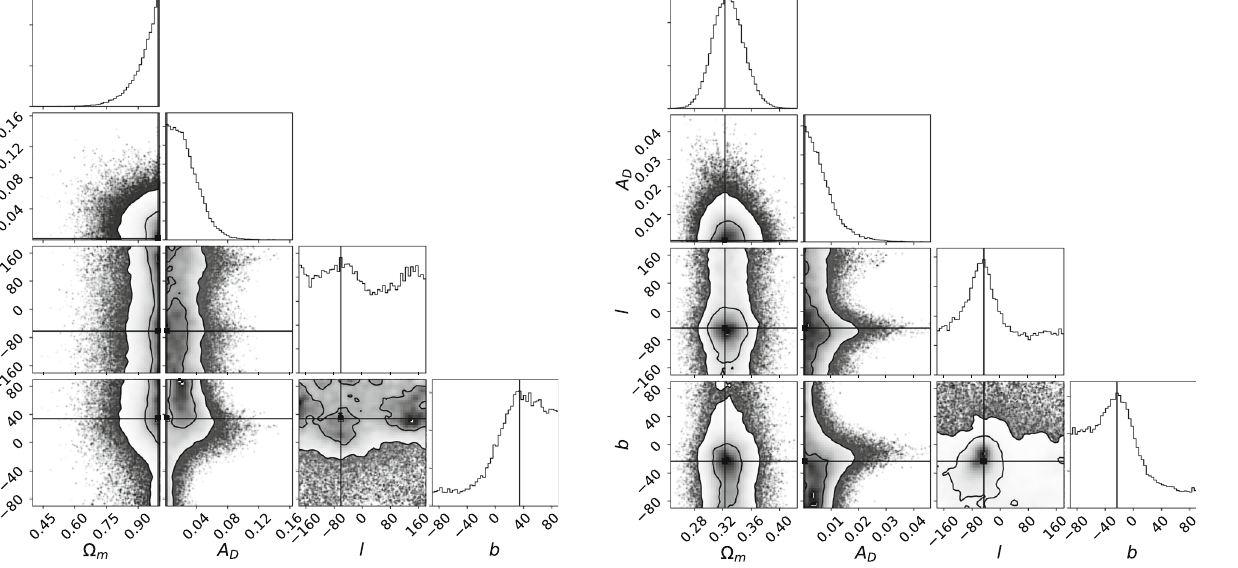
Fig. 7 The marginalized posterior distribution of the parameters in the Finslerian cosmological model from the 2020 quasar compilation and Pantheon sample. The horizontal and vertical solid black lines denote the maximum of 1-dimensional marginalized posteriors